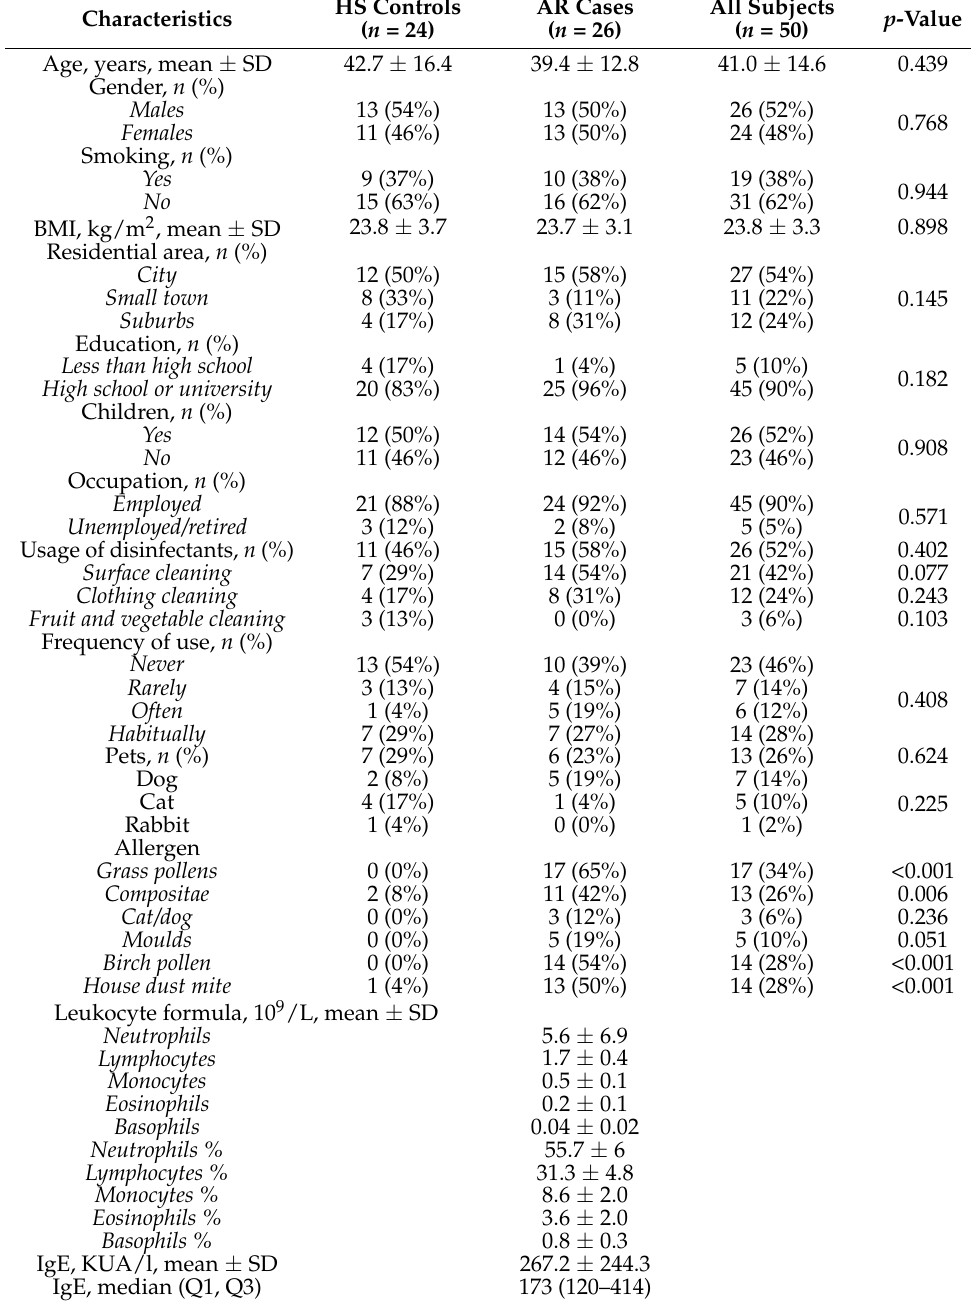
Table 1. Characteristics of the study participants (N =